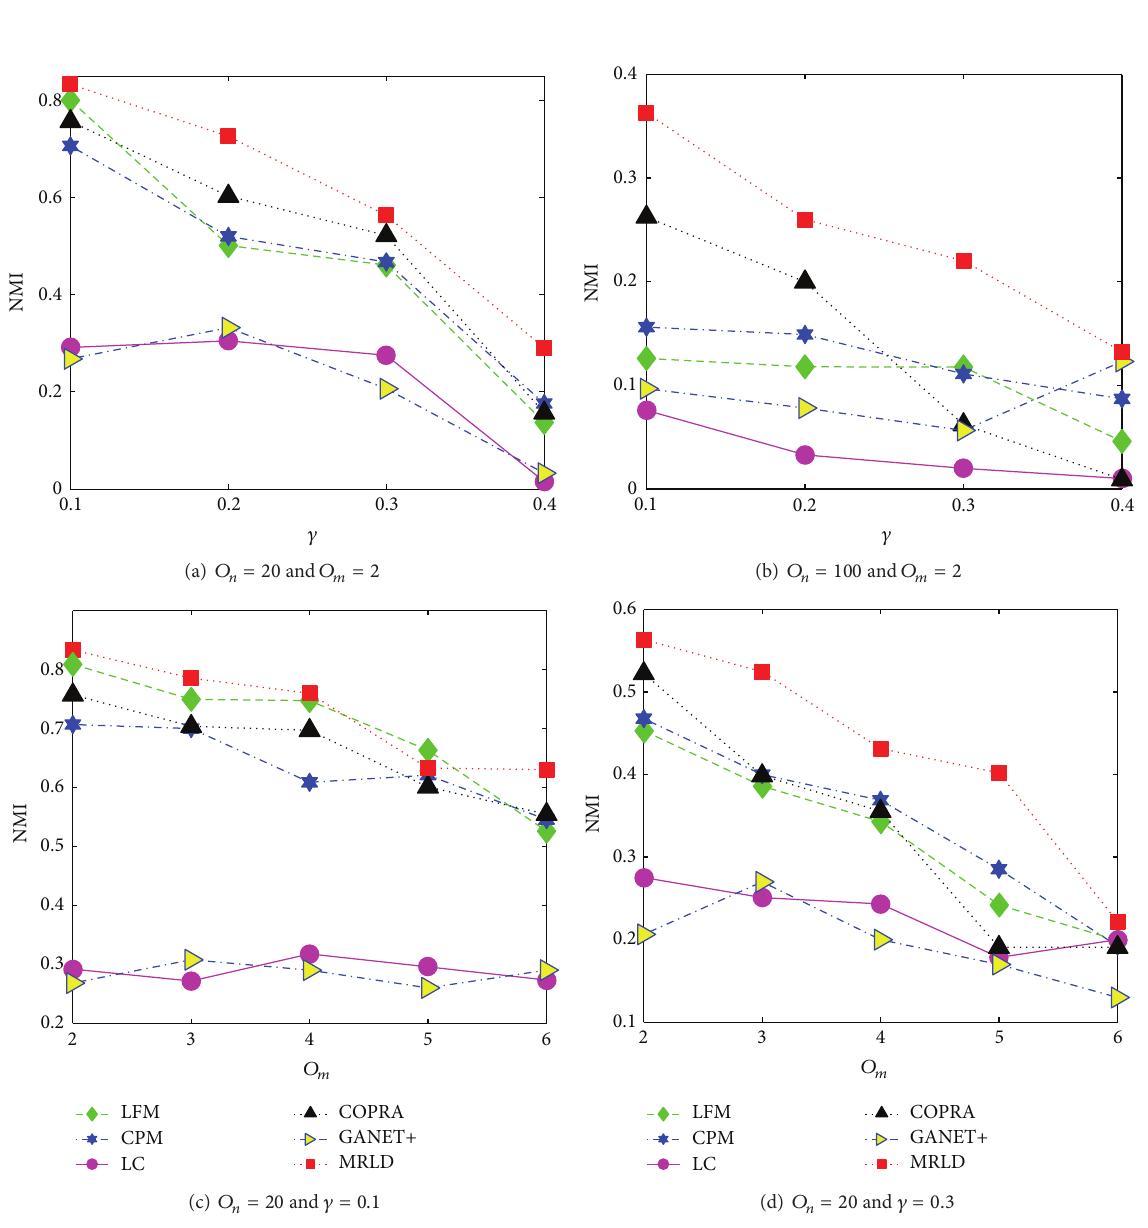
Figure 4: Comparison of MRLD with other algorithms in terms of